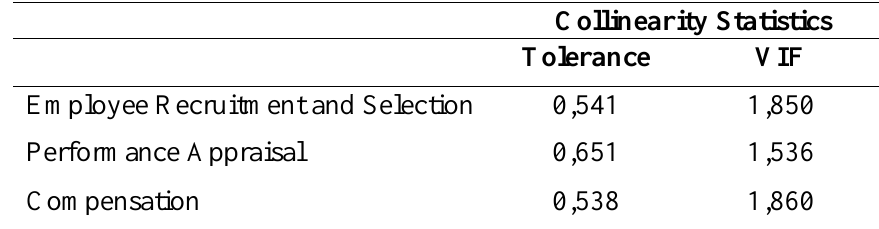
Multicollinearity Test